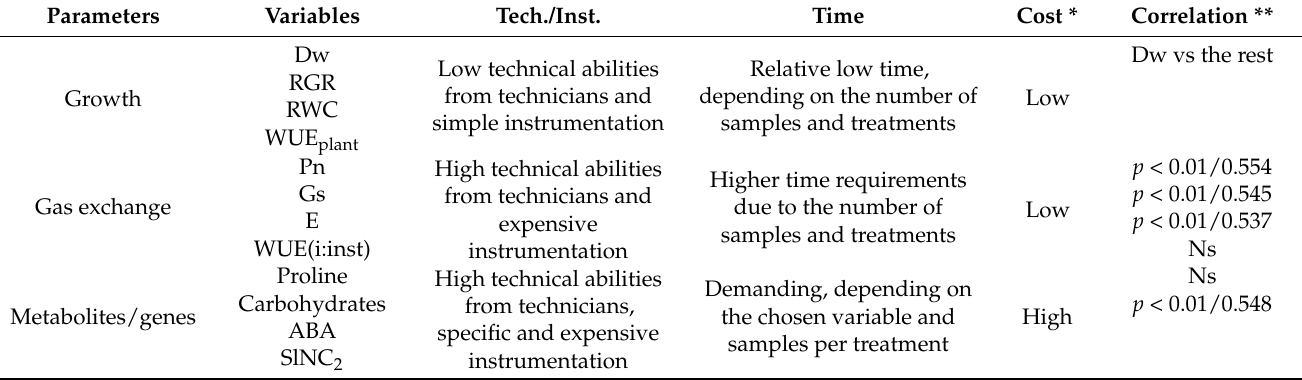
Table 2. Qualitative and statistical analyses of the variables used to characterise the water-deficit treatments in tomato seedlings under experimental conditions. Dw, dry weight; RGR, relative growth rate; RWC, relative water content; WUEplant, plant water use efficiency; WUE(i:inst). Parameters Variables Tech./Inst. Time Cost * Correlation